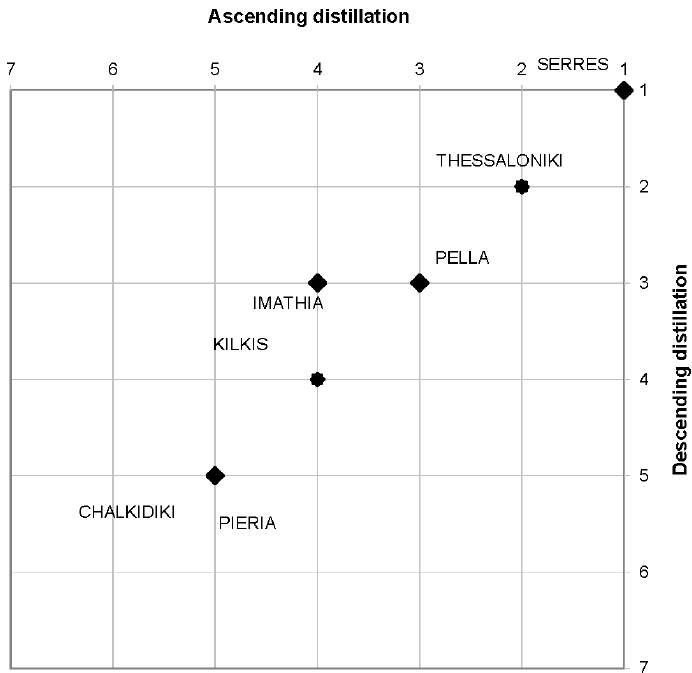
Figure 1. Ascending and descending distillations of the optimal agro-energy region for the biomass